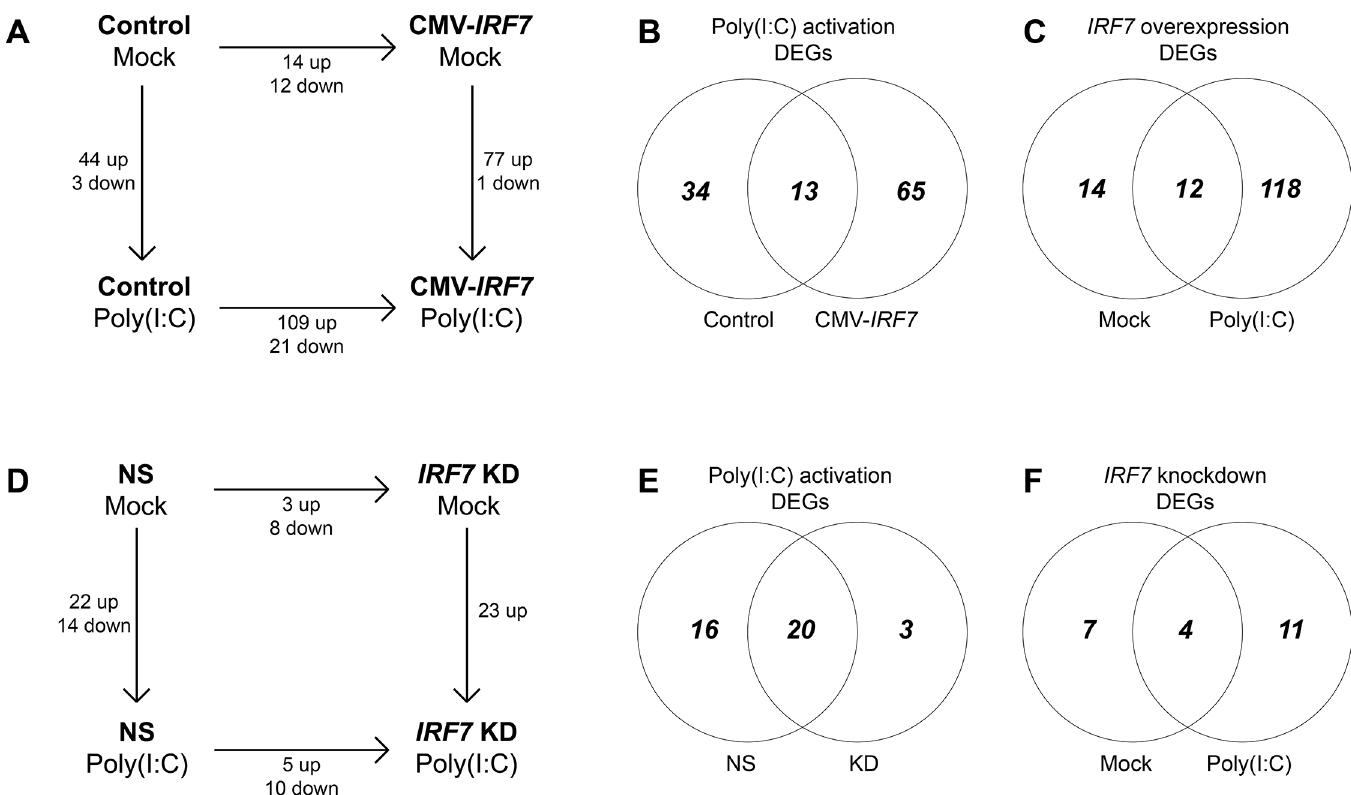
Fig 3. Differential expression analyses of RNA-seq samples. Differentially expressed genes (DEGs) between cell lines and treatments in the (A) overexpression and (D) knockdown data set. (B, E) Venn diagrams of overlapped DEGs between cell lines upon poly(I:C) expression. (C, F) Venn diagrams of overlapped DEGs between treatments in effect of IRF7 expression